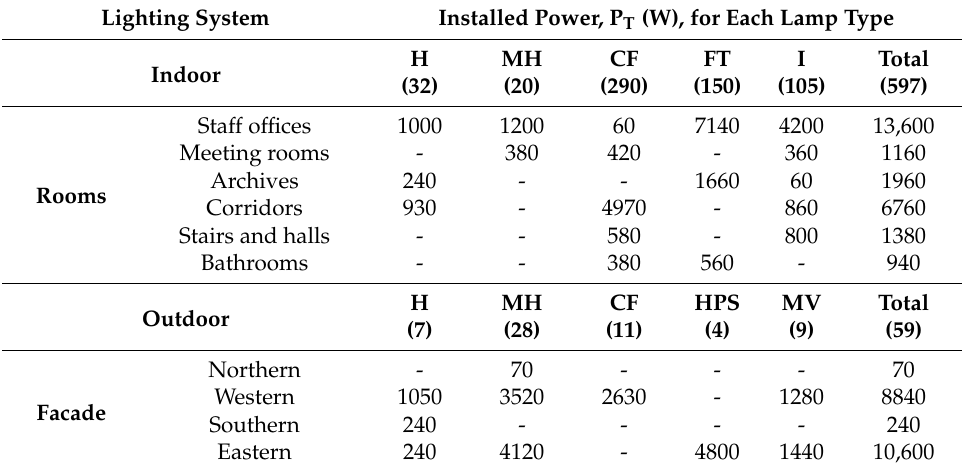
The symbols used for the lamp types are: H = halogen, MH = Metal halide, CF = compact fluorescent, FT = fluorescent tube, I = incandescent, HPS = high pressure sodium, MV = mercury-vapour. In the brackets the total number of each lamp type is indicated.